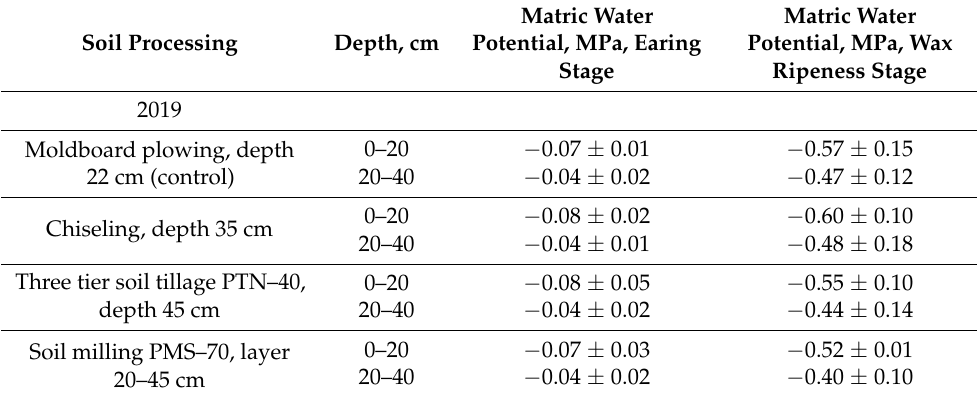
Table 6. Matric water potential after different options of soil mechanical treatment. Soil Processing Depth, cm